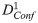
Three representative conformations for ssDBP-ssDNA and ssRBP-ssRNA.The conformations are sampled from simulations that correspond to the densely populated regions labelled 1, 2, and 3 in Fig 3 are shown in green, red, and blue, respectively, for each of the ssDBP–ssDNA (top, red square) and ssRBP–ssRNA (bottom, blue square) complexes. All-atom cartoon representations of the protein (in gray) and of the bound conformation of the ssDNA or ssRNA (in orange) are shown for comparison. The lowest energy green ssDNA/ssRNA conformations (region 1) are most similar to the orange experimental conformations (lower values of DConf1 and DConf2 and of DSite1 and DSite2), which demonstrates the predictive power of the model.